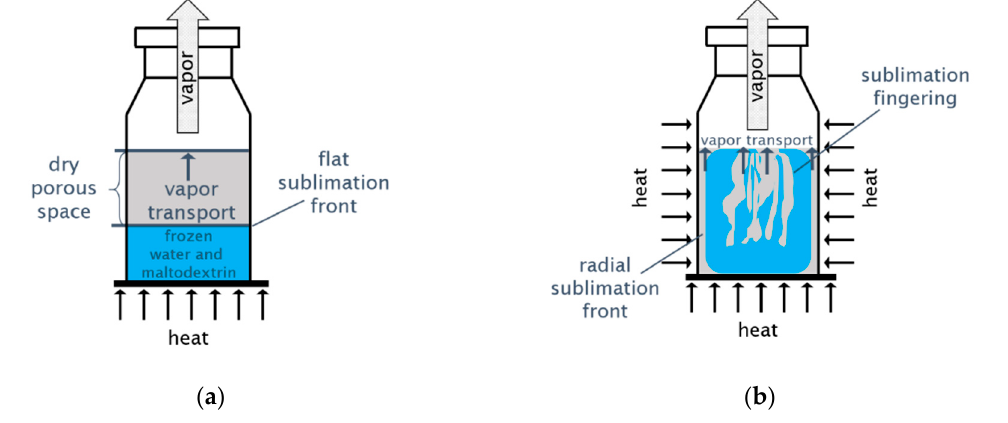
Figure 1. ( a ) Freeze-drying of liquid solutions with a flat sublimation front that travels from top to bottom during drying. ( b ) Heterogeneous sublimation with the formation of distinct structures and different sublimation zones.